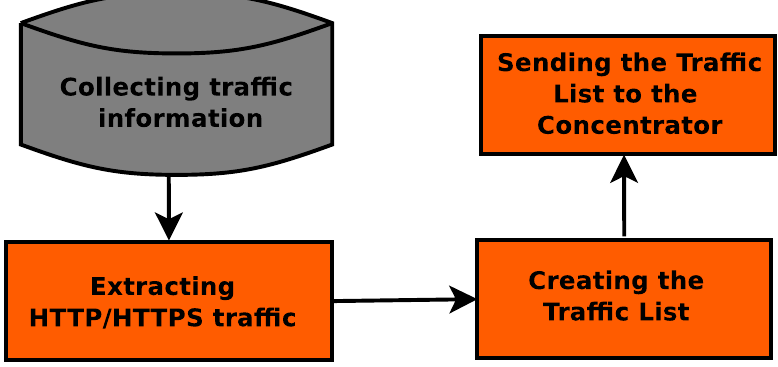
Figure 6. Collection module (CM) flowchart.